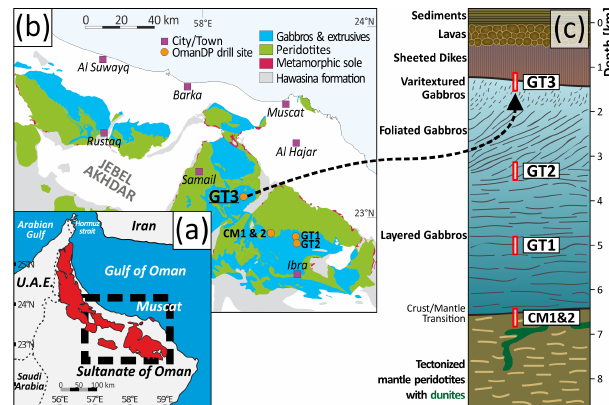
Figure 2. Maps and lithostratigraphic column of the Oman ophio- lite. (a) Geographical overview. (b) Geological map with locations of the OmanDP crustal drill sites. (c) Lithostratigraphic sequences of typical oceanic crust formed at fast-spreading ridges including the positions of the OmanDP crustal drill sites. Panels (b) and (c) modified after Kelemen et al. (2020).